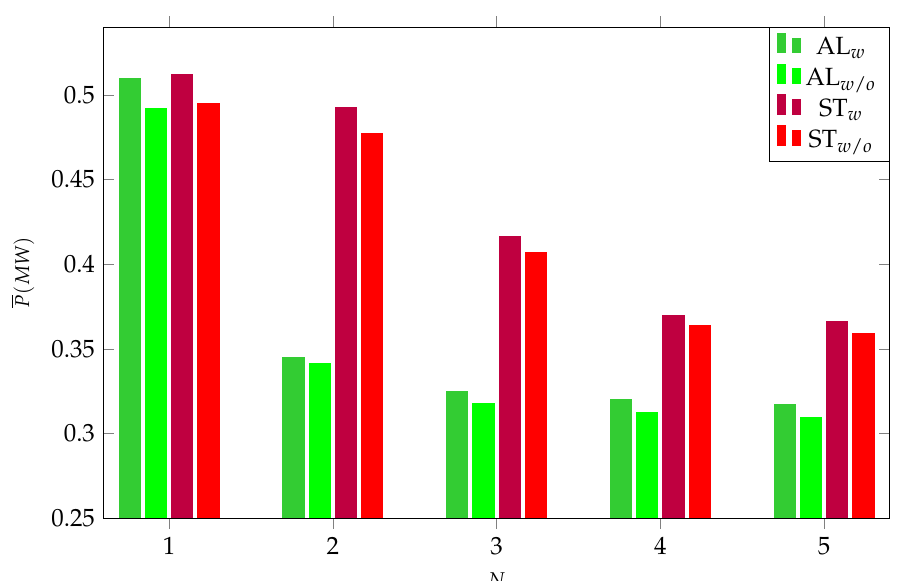
Figure 11. The mean production per row. The numbers of rows is N . For the aligned configuration, the lime green bar (AL w ) corresponds to the case with blockage correction and the green bar (AL w / o ) to the case without blockage correction. For the staggered configuration, the purple bar (ST w ) corresponds to the case with blockage correction and the red bar (ST w / o ) to the case without blockage correction.